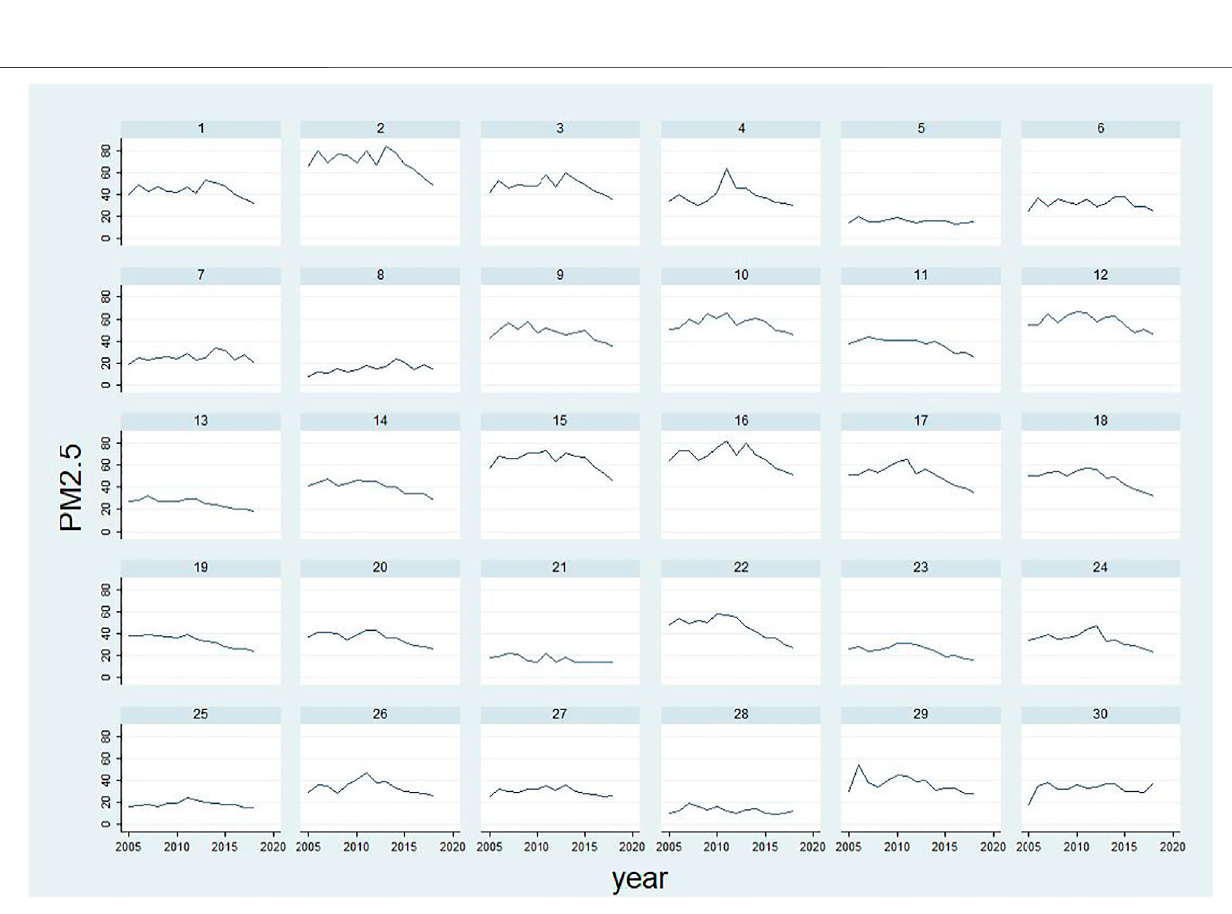
Frontiers in Environmental Science |